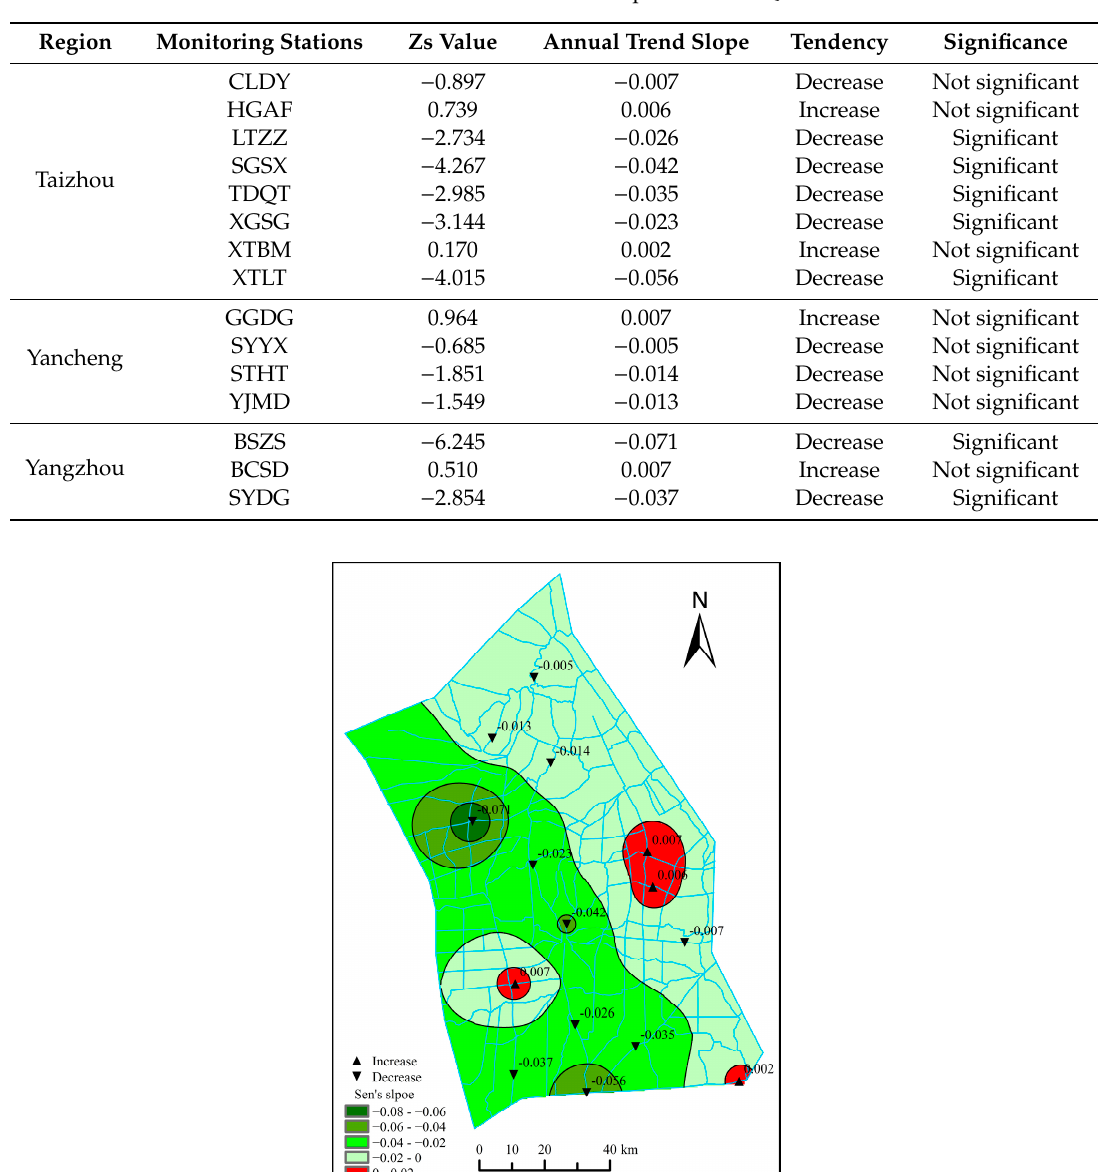
Table 6. The trend and trend slope of the CWQI.